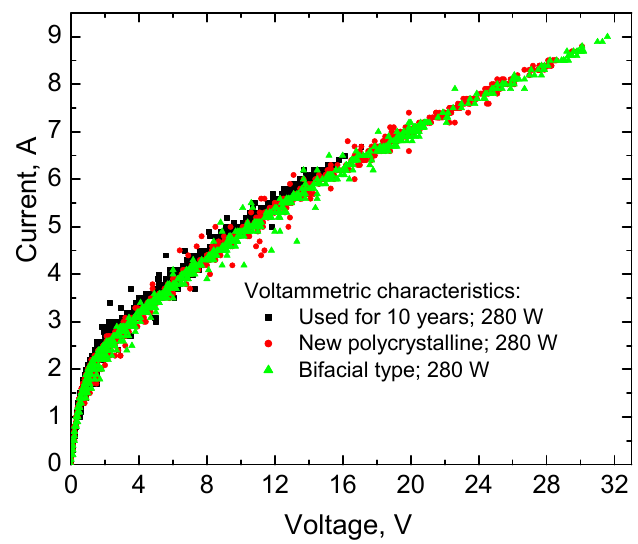
Figure 10. Volt-ampere characteristics of different solar cells.